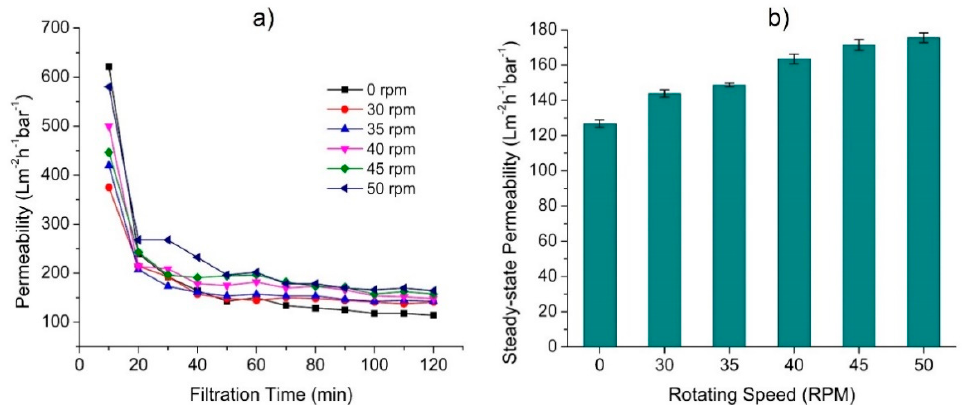
Figure 5. The effect of rotating speed on the membrane permeability permeance showing ( a ) the evolution of permeability as function of filtration time, and ( b ) the steady-sate permability value taken as the average of the final 30 min filtration. The system was run at a membrane-to-disk gap of 1.5 cm.